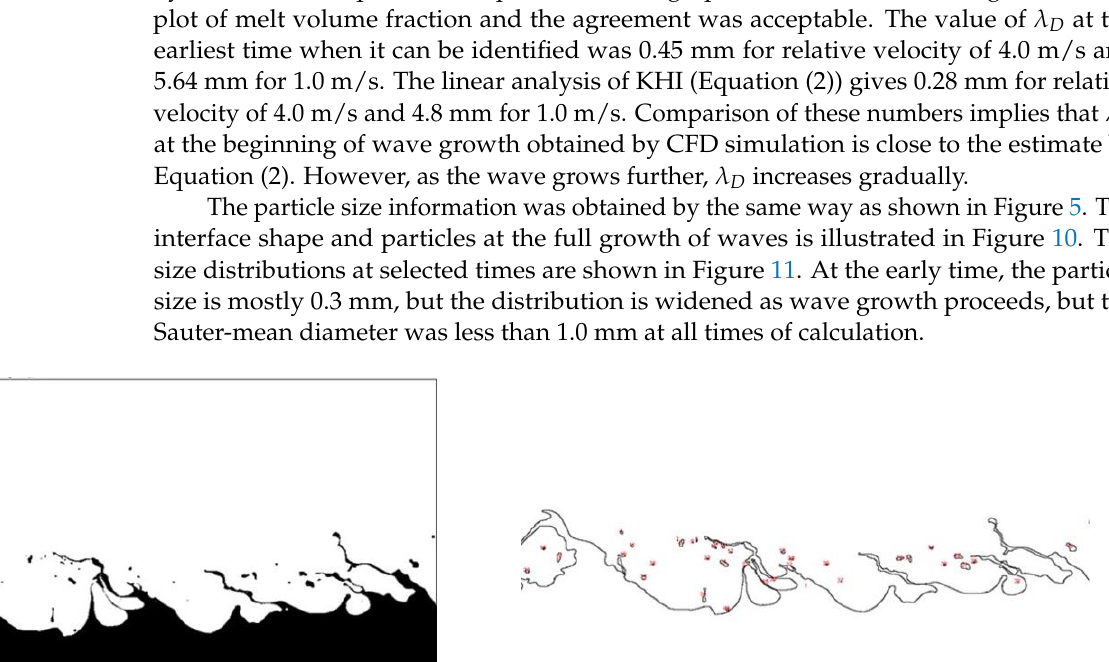
Figure 9. Wavelength analysis by Fast Fourier Transform (FFT) technique on melt volume fraction: melt volume fraction near interface ( left ), FFT spectrum ( right ).